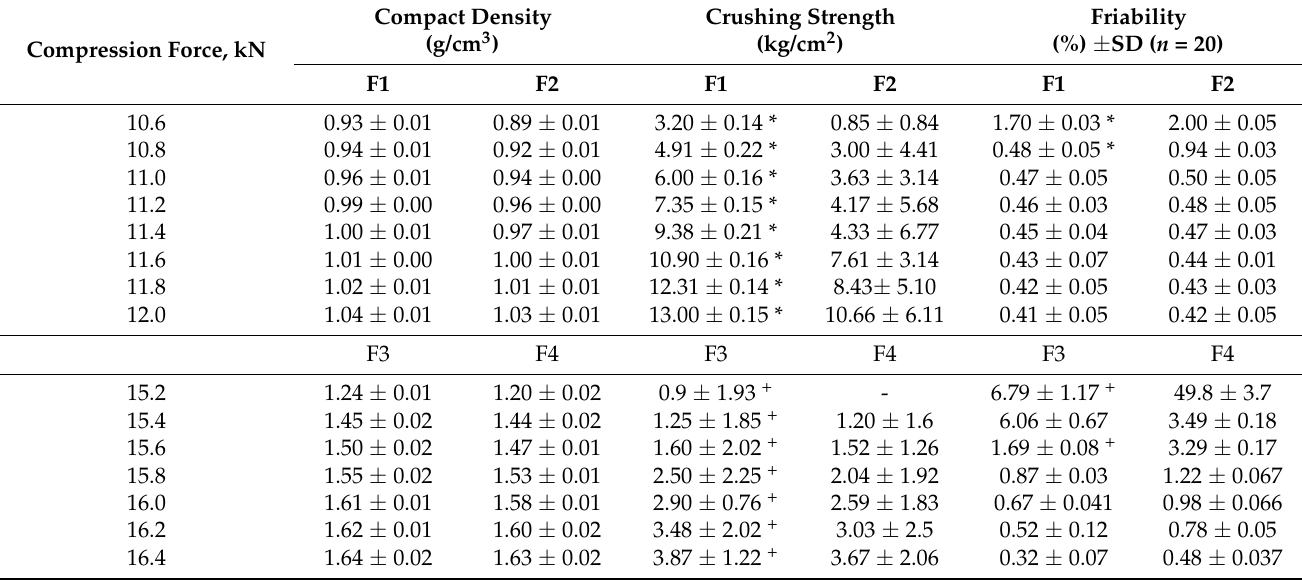
Table 4. The physical properties of meloxicam tablets of formulations F1, F2, F3, and F4.